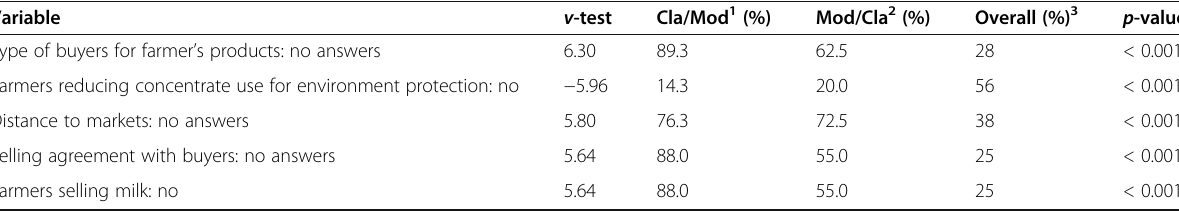
Table 3 Top 5 relevant categorical variables that best describe the 40 farms from cluster 1. Overall sample n = 100 farms Variable v -test Mod/Cla 2 (%) Overall (%) 3 p -value